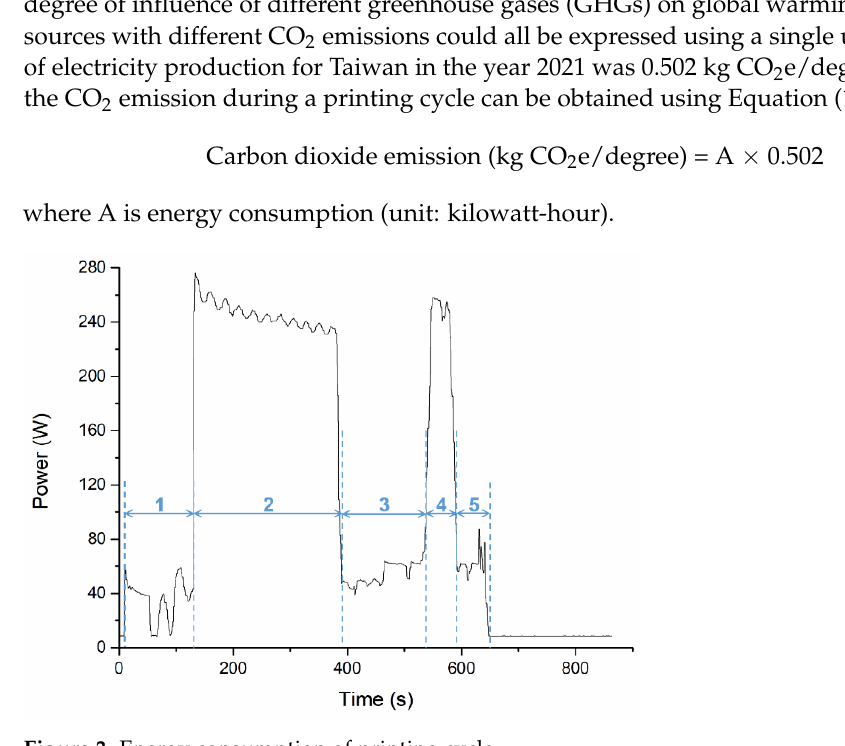
Figure 3. Energy consumption of printing cycle.